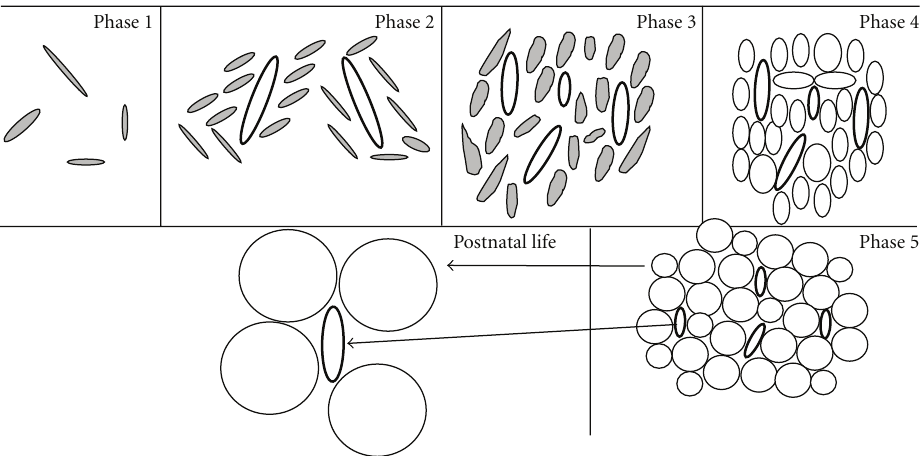
Figure 1: Developmental stages of adipose tissue (adapted from Brooks and Perosio, [17]). Phase 1: emergence of loose connective tissue composed of an amorphous ground substance and stellate cells (filed). Phase 2: aggregates of mesenchymal cells (filed) are condensed around proliferating primitive blood vessels (bold ovals). Phase 3: mesenchymal cells di ff erentiating into stellate preadipocytes within a glomerulus. Phase 4: appearance of adipocytes with multiple small lipid droplets closely packed around the capillaries. Phase 5: fat lobule with many unilocular cells (clear circles) is evident. This developmental process (phase 1 to 5) occurs between the 14- and 23-week gestation period. From 23 to 29 weeks, the number of fat lobules is relatively constant. From the 23rd to 29th week and throughout postnatal life, the growth of adipose tissue is determined mainly by an increase in size of the fat lobules arising from adipocyte hypertrophy and enlargement of adipose